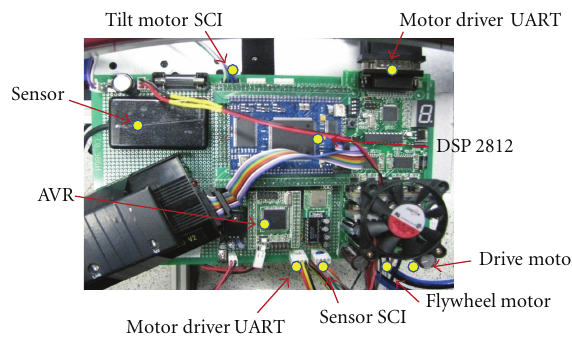
Figure 12: Control hardware.